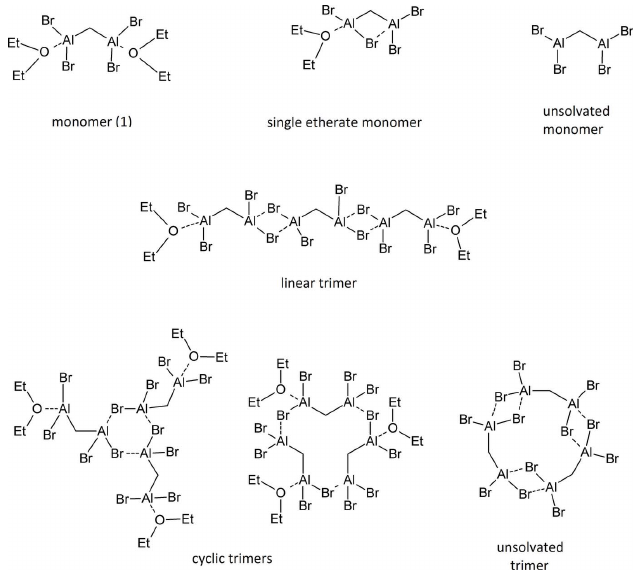
Figure 8 Drawings of some possible structures of monomeric and trimeric aggregates of 1 , with varying degrees of ether coordination. The possibilities exhibited here are not exhaustive.